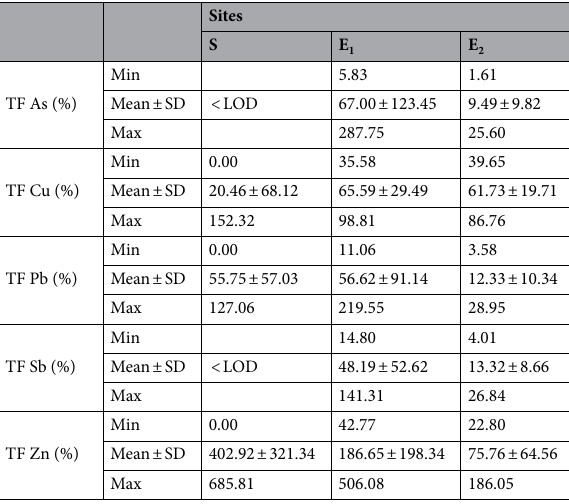
Table 6. Translocation factors (TF) in Coronilla juncea individuals i.e. ratios of PTE aerial part concentration vs. PTE root concentration in the topsoil (0 to 10 cm depth) for As, Cu, Pb, Sb and Zn. Min: minimum; Max: